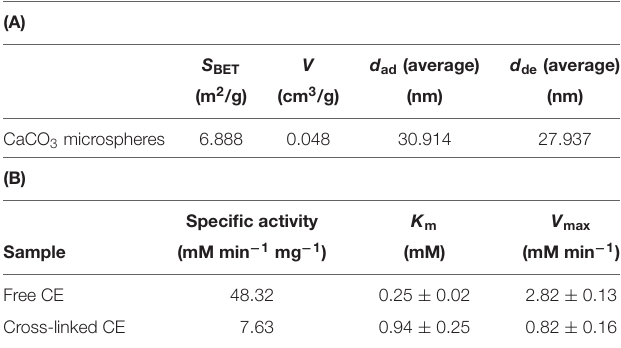
TABLE 1 | Characteristics of (A) CaCO 3 microspheres, and (B) free CE and cross-linked CE (A) .